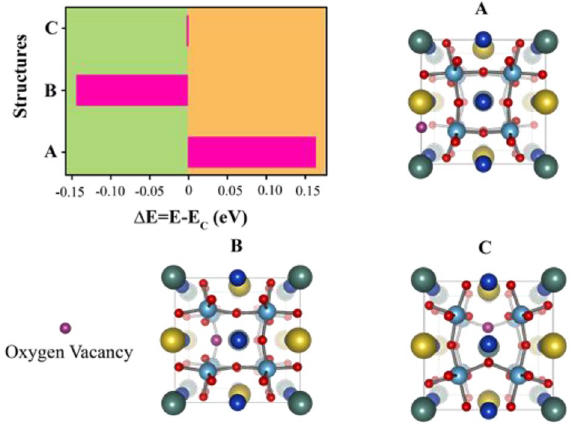
Figure 14. Total energy of various positions of oxygen vacancy in the NYTO lattice in comparison to total energy of Structure C. Structure A is a structure with an oxygen vacancy between Na and Y ions. For Structure B, the oxygen vacancy is coupled with both Na and Cu in the NYCTO structure. V o is close to Y labelled in Structure C.